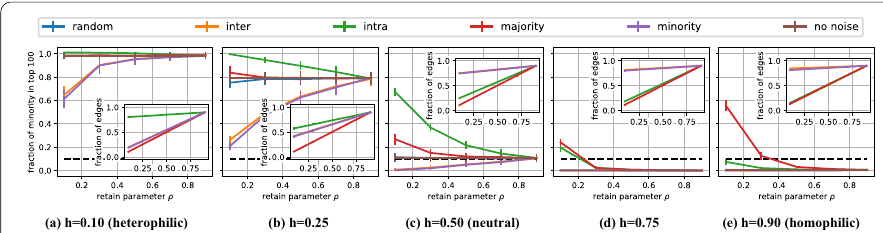
Fig. 3 Impact of node attribute-based noise on the representation of minority nodes in rankings on synthetic networks. We visualize the fraction of minority in the top 1% (top 100) nodes as a function of the retain parameter ρ . Note that low values of ρ correspond to a strong noise (noise decreases from left to right in every subplot). We increase the homophily parameter h from the leftmost to the rightmost panel. The main plots show the representation of the minority in a degree-based ranking while the insets show the impact of ρ on the number of edges in the network. We can see that in heterophilic regimes the original minority representation is already affected by relatively weak noise. In contrast, the representation in homophilic regimes is only affected for much stronger noise. This shows that node attribute-based, systematic noise can have a variety of effects which depends on the homophily of the